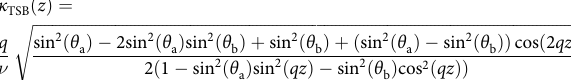
the starting point of an integral curve, such that Eq. (5) actually yields an in fi nite collection of curves, all identical except for a translation in x and y . For a generic twist-splay-bend (TSB) phase the integral in Eq. (5) cannot be evaluated analytically. However, the tendency of particles to align their pro fi les to the nematic director fi eld at low temperatures or high densities, corresponds to a tendency to match their particle curvature with the curvature of its integral curves. Given a curve r ( z ) with tangent r 0 ð z Þ ¼ ν ^ n ð z Þ of constant norm k r 0 ð z Þ k¼ ν , we can reparametrize it by its arc length as r ( s = ν z ). In this reparametrization the tangent to the curve r 0 ð s Þ ¼ ð ∂ r ð z Þ = ∂ z Þ z 0 ð s Þ ¼ ^ n ð s Þ has unit norm, and we can calculate the curvature of the integral curve as κ ð s Þ ¼k ^ n 0 ð s Þ k . Going back to the original parametrization, we obtain κ ð z Þ ¼k ^ n 0 ð z Þ k = ν . Using this formula, we obtain the following curvature for the integral